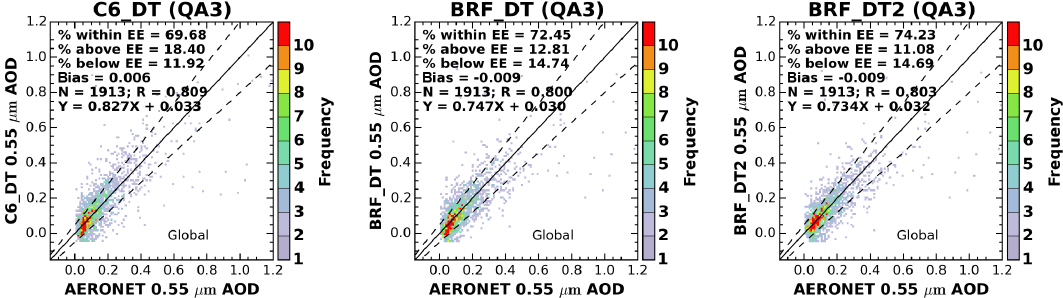
Figure 12. DT AOD validation over the global land. The DT algorithms are C6_DT, BRF_DT and BRF_DT2. The retrieved AOD is filtered with QA = 3 (labeled as QA3), shown against AERONET AOD. The dash and solid line are expected error (EE) ± ( 0 . 05+15% ) and one–one line, respectively.